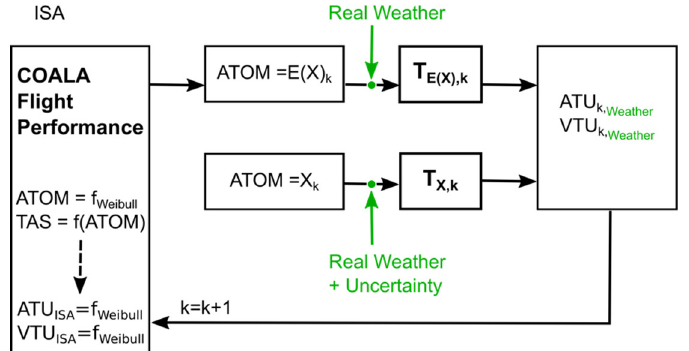
Figure 4. Developed cause-and-effect model for trajectory prediction and trajectory tracking with probabilistic uncertainties in the input parameters ATOM, weather and TAS.